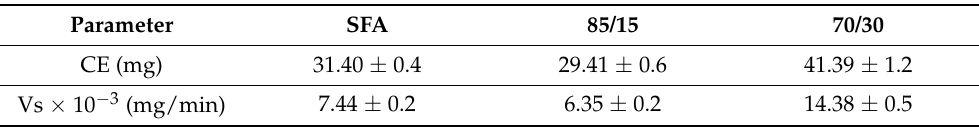
Figure 6. Progressive mass loss during exposure to cavitation. Table 3. Values of the cumulative erosion (CE) after 1800 min of exposure to cavitation and of the terminal erosion rate (Vs).